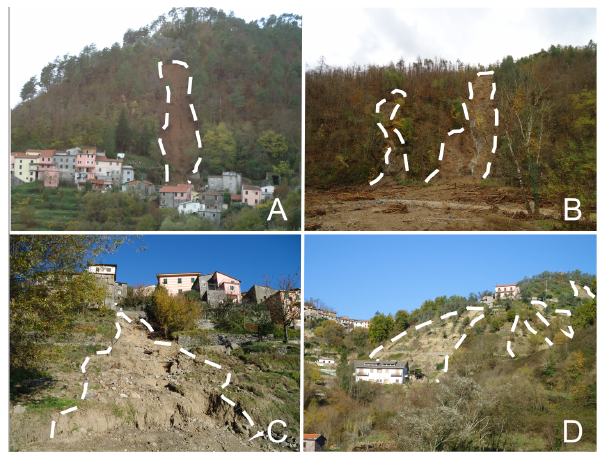
Figure 2. Examples of landslide types mapped in the Pogliaschina catchment: (A) and (B) are earthflows, (C) and (D) are soil slips. Figure 2 Examples of landslide types mapped in the Pogliaschina catchment. (A) and (B) are 624 earthflows. (C) and (D) are soil slips. 625 sampling distance (GSD) panchromatic band, and four 2 m GSD multispectral (blue, green, red, NIR) bands. The satel- lite images were provided in UTM WGS84